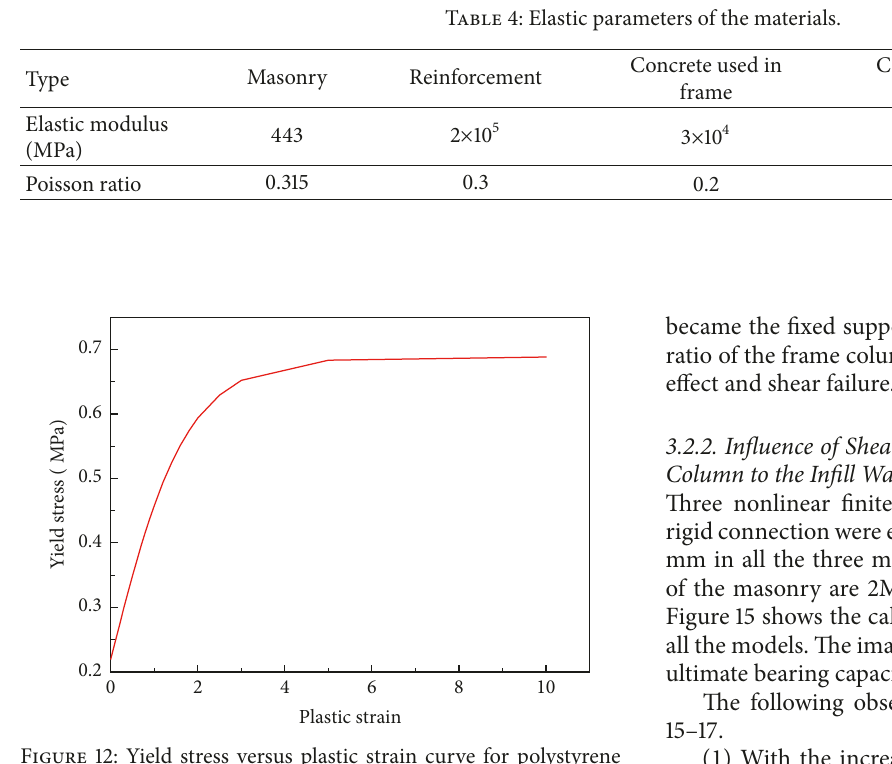
Figure 12: Yield stress versus plastic strain curve for polystyrene foam board.